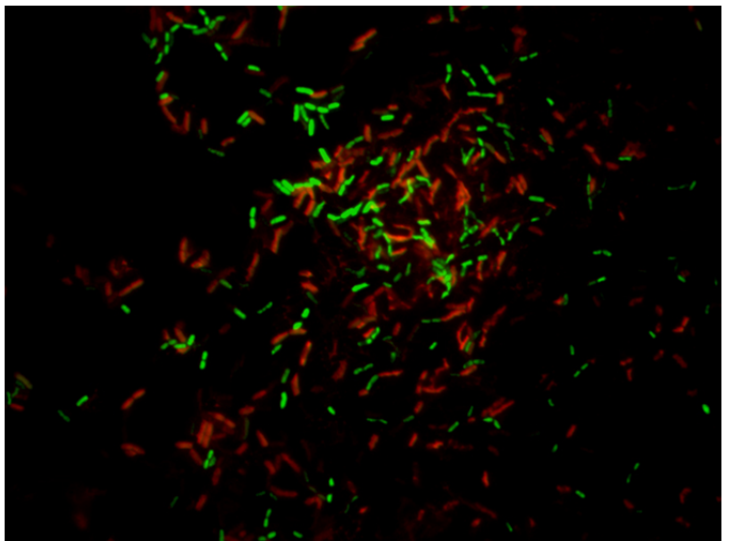
Figure 3. Planktonic state of Pseudomonas fluorescens stained with LIVE/DEAD (SYTO 9 and propid- ium iodine) after treatment with sodium hypochlorite (500 ppm) for 15 min. Viable bacteria (green) and damaged bacteria (red). Magnification ×100.